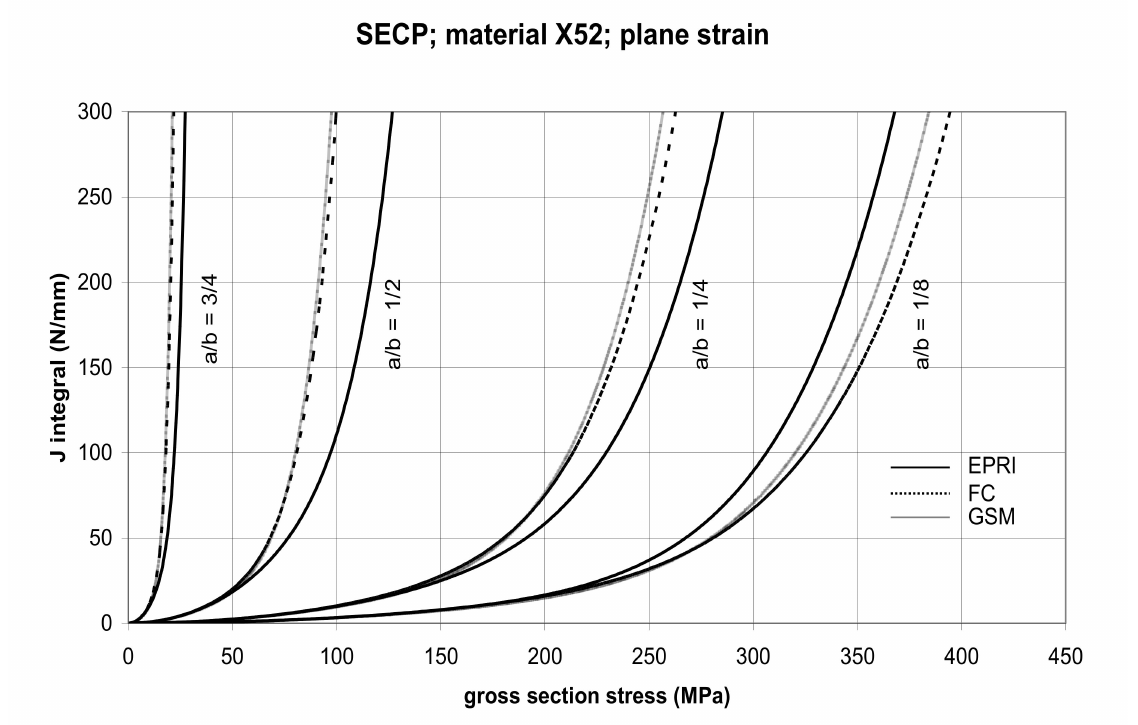
Figure 15. Comparison of J integral for SECP X52 steel specimens in the plane strain condition as determined by the EPRI, GSM, and FC